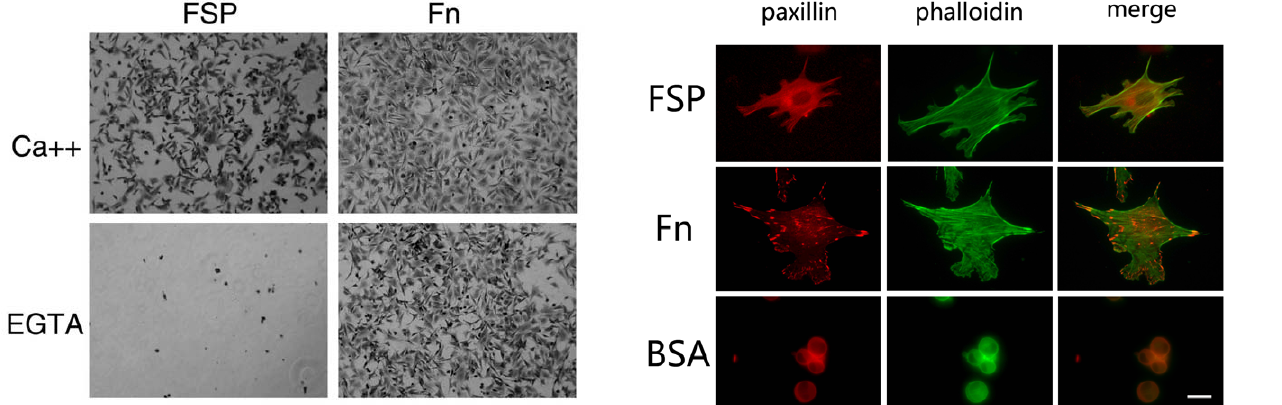
Figure 6. FSP induces the formation of actin stress fibers, filopodia, and lamellipodia. Serum-starved cells were plated on coverslips coated with FSP ( A ), Fn ( B ), or BSA ( C ) for 3 hr at 37 u C. Cells were immunostained for paxillin, and were counterstained with phalloidin green. Paxillin was localized in filopodia formed in the cells spreading on the FSP substrate. Scale bar=8 um for all